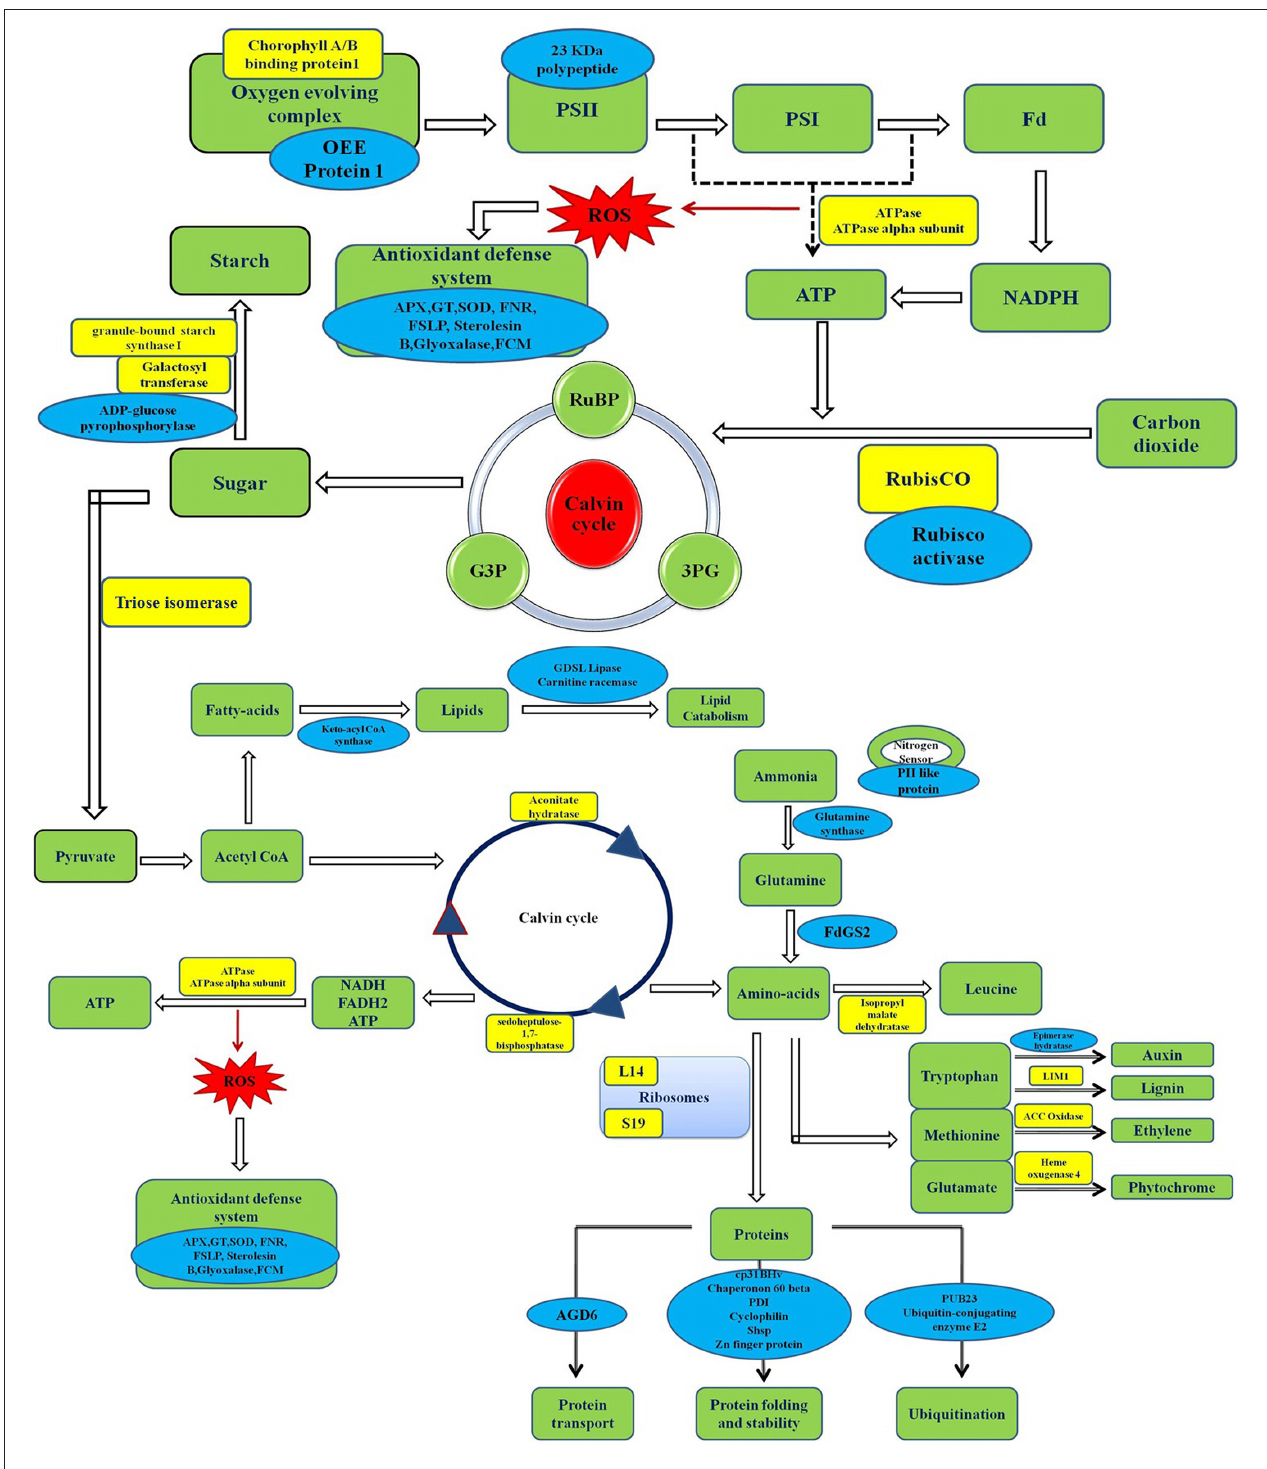
FIGURE 5 | Schematic representation of differentially-expressed proteins in Indian mustard grown under teratments of [CO 2 ] and N. Proteins in yellow boxes were downregulated whereas those in blues boxes were upregulated. OEE protein1, Oxygen evolving enhance protein1; RUBP, Ribulose-1,5-bisphosphate; 3PG, 3-phosphoglycerate; G3P, Glyceraldehyde 3-phosphate; FdGS2, Ferredoxin-dependent glutamate synthase 2; AGD6, AGD6 ARF GTPase activator/DNA binding/zinc ion binding; GT, Glutathione transferase; FNR, Fd-NADP reductase; FCM, Flavin-containing monooxygenase.